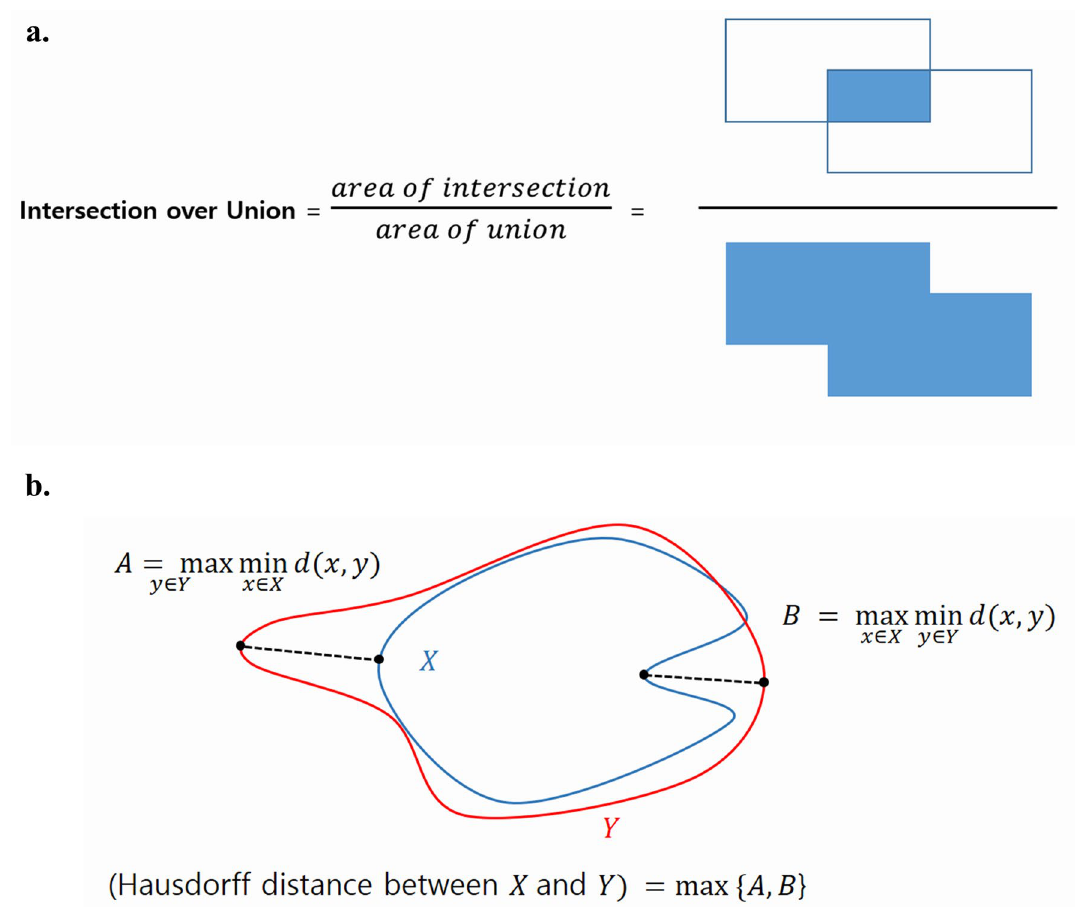
Figure 3. Graphical visualization of the intersection over union ( a ) and the Hausdorff distance ( b ). d in ( b ) denotes the distance between two